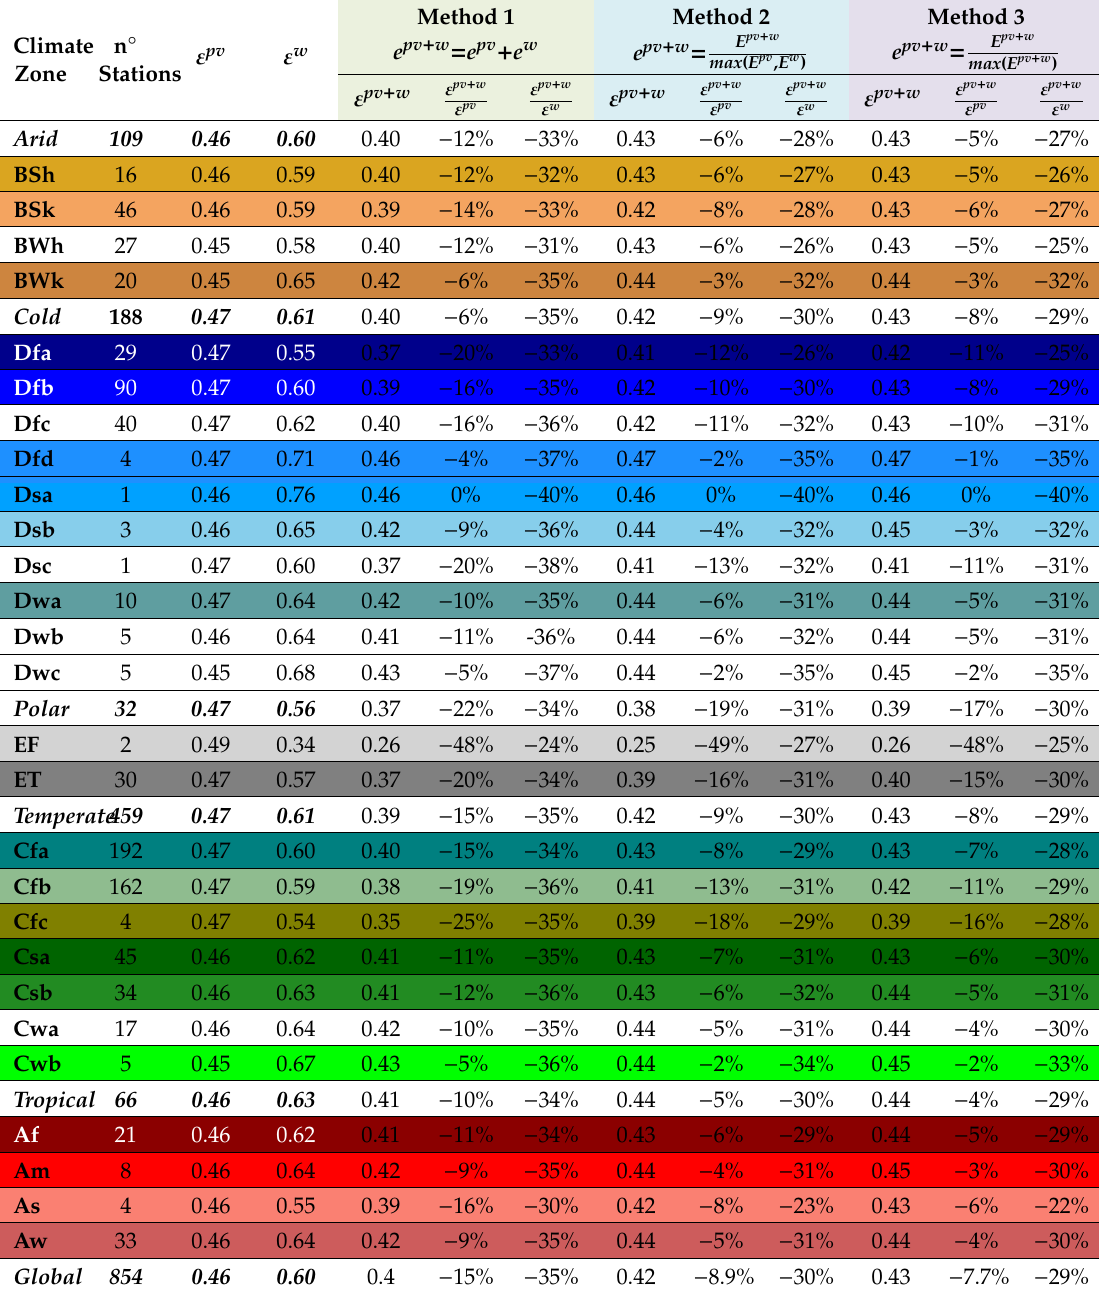
Table 8. ε pv , ε w and ε pv + w for every single individual Köeppen–Geiger climatic regions (See Figure 4 for climate zone